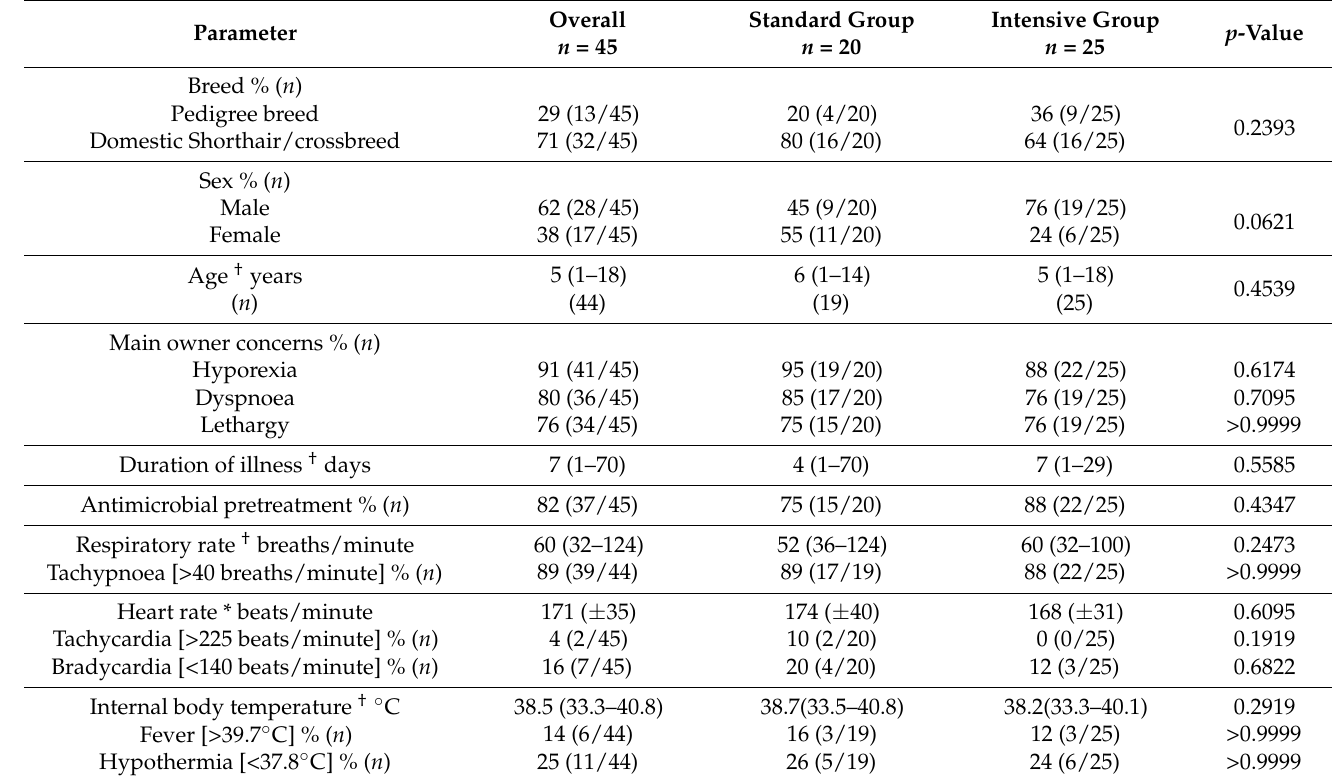
Table 2. Signalment, medical history and physical examination findings.